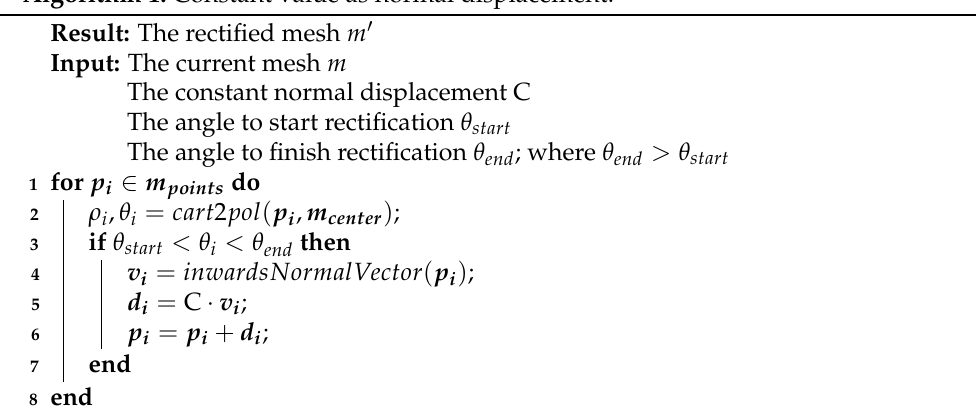
Algorithm 1: Constant value as normal